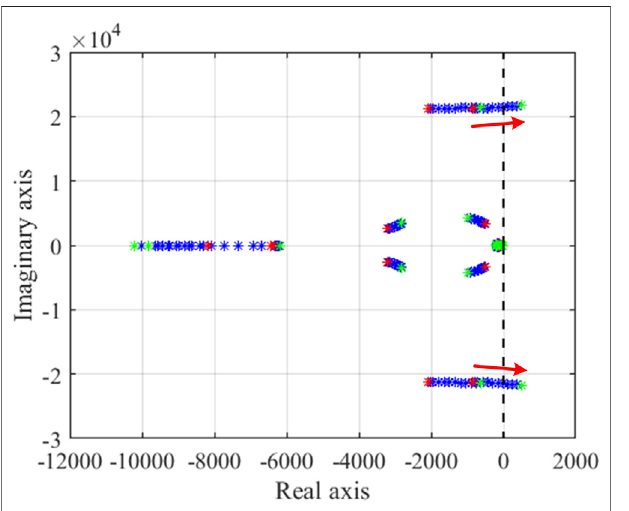
FIGURE 10 | Root locus with the change of kpv (PV